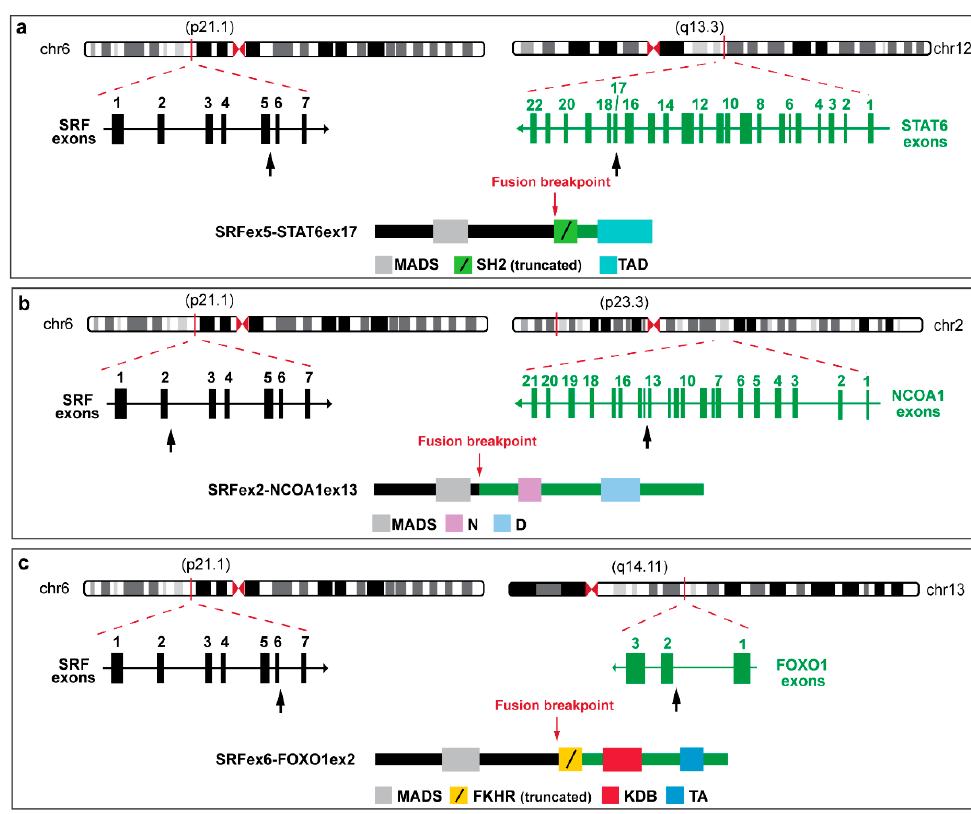
Figure 7. Schematic representation of SRF -fusion transcripts and predicted chimeric proteins, de- picting the exons and protein domains involved. The genomic exon structure of the SRF and fusion partner genes are reported on the left and on the right, respectively: SRF::STAT6 ( a ) [9], SRF::NCOA1 ( b ) [8] and SRF:: FOXO1 ( c ) [8]. Black arrows indicate breakpoints. Resulting chimeric proteins for each fusion transcript are reported at the bottom of each figure. MADS: MAD box DNA-binding domain; SH2: Src homology domain 2; TAD: transactivation domain; N: nuclear receptor coactiva- tor; D: domain of unknown function; FKHR: forkhead DNA-binding domain; KBD: KIX-binding domain; (protein interacting domain) and TA: transcription activator domain.